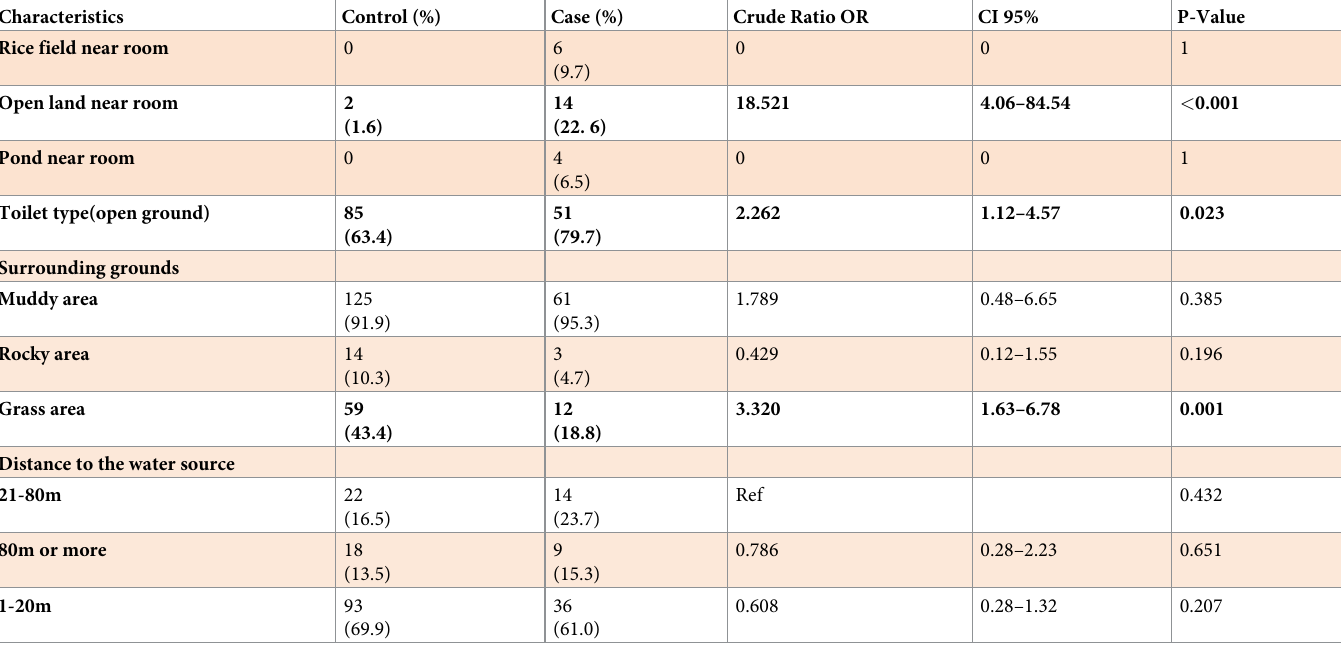
Table 3. Bivariate analysis of characteristics around the house as risk factors of VL.